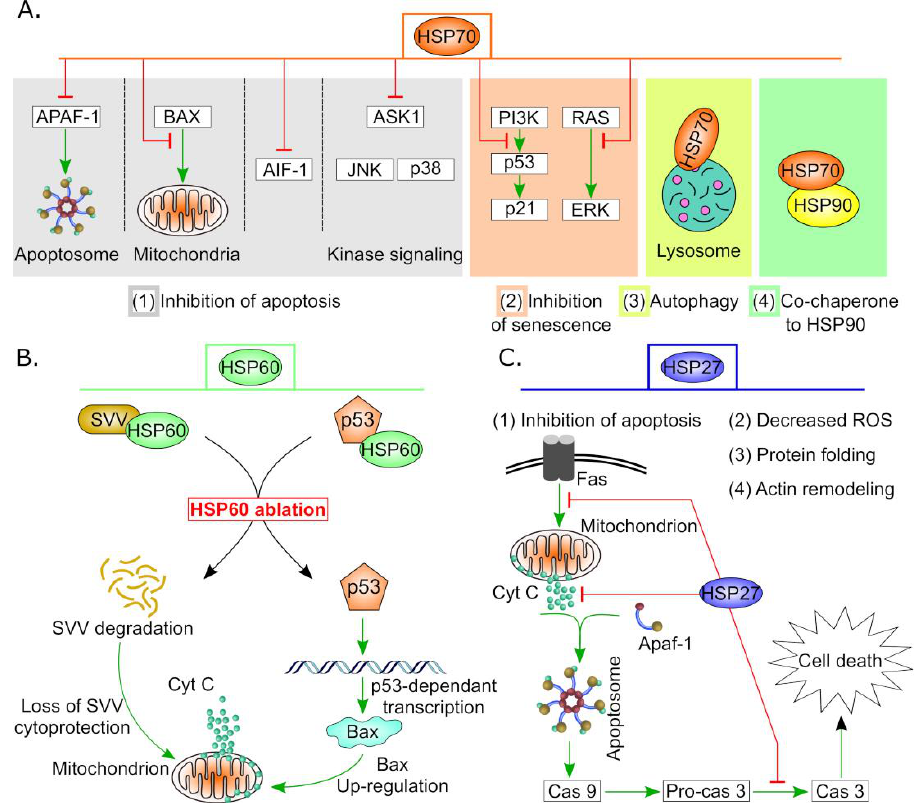
Figure 2. Anti-apoptotic and cell survival activities of some HSPs in cancer. ( A ) Variant roles of HSP70 in carcinogenesis. High expression of HSP70 in tumor cells suppresses apoptosis by (1) hindering APAF1 recruitment to apoptosome, interfering with BAX translocation to mitochondria, downregulation of AIF1 and other stress-related kinases. Additionally, (2) HSP70 regulates both p53-dependent and -independent senescence pathways, (3) supports autophagy by stabilization of lysosomal membrane and finally (4) it forms complex with HSP90 which is essential for efficient functionality. ( B ) HSP60 controls apoptosis by stabilizing mitochondrial survivin (SVV) and hindering P53 pro-apoptotic actions. HSP60 ablation results in degradation of SVV and activation of the mitochondrial apoptotic pathway. In addition, silencing of HSP60 increases P53 stability and subsequently, triggers p53-dependent transcription of apoptotic proteins such as BAX which promotes cell death [46]. ( C ) HSP27 performs multiple functions in cancer including protein folding, actin remodeling, minimizing oxidative stress and inhibition of apoptosis. Sample anti-apoptotic events of HSP27 are indicated by red blunt arrows.